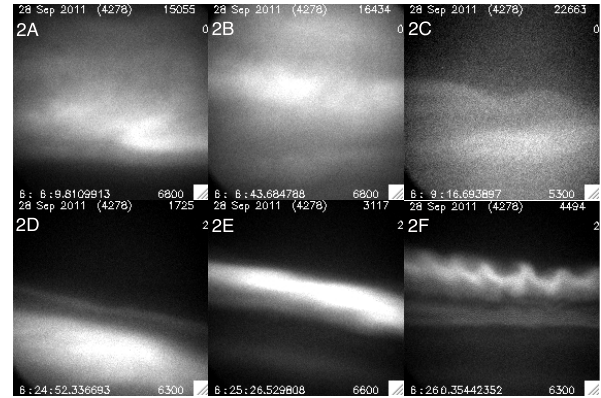
Figure 7. Event 2: narrow-field images (15 ◦ FOV) – taken on 28 September 2011 with a 427.8nm filter – showing the small-scale structure of the aurora at the times of the NEIALs in the PFISR data (labeled 2A–2F). The magnetic zenith – the location of the radar beam ( ∼ 1 ◦ beamwidth) – is located near the center of each image. Same orientation as Fig. 6.